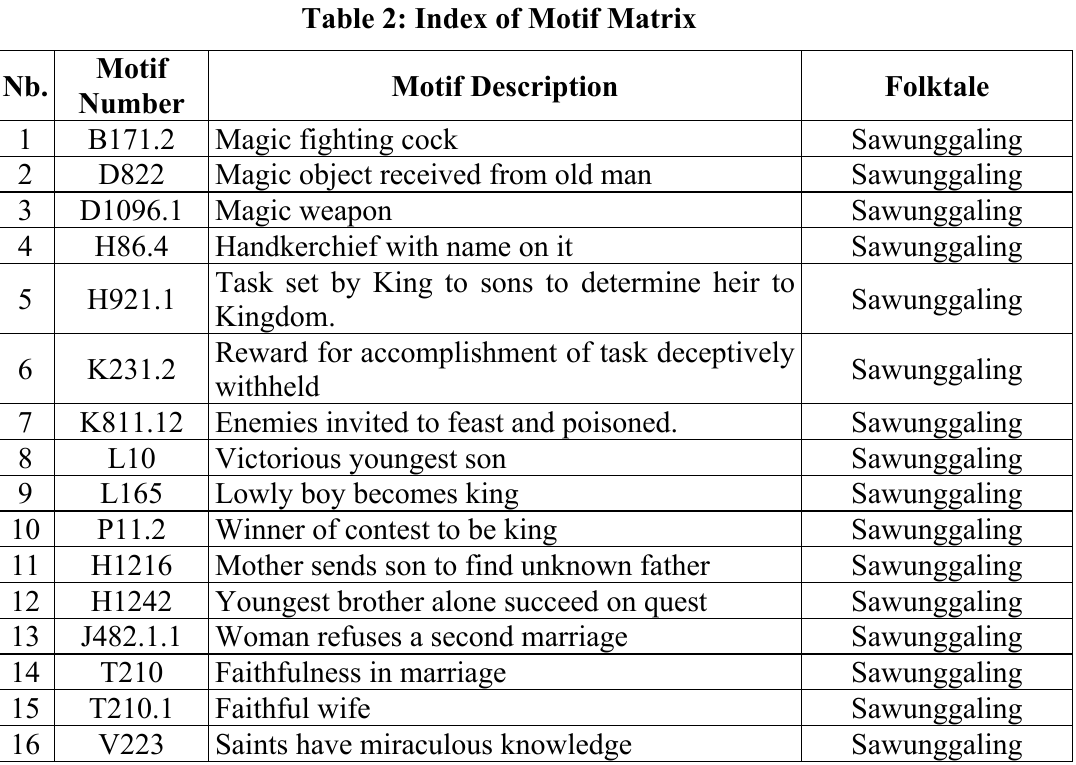
Table 2: Index of Motif